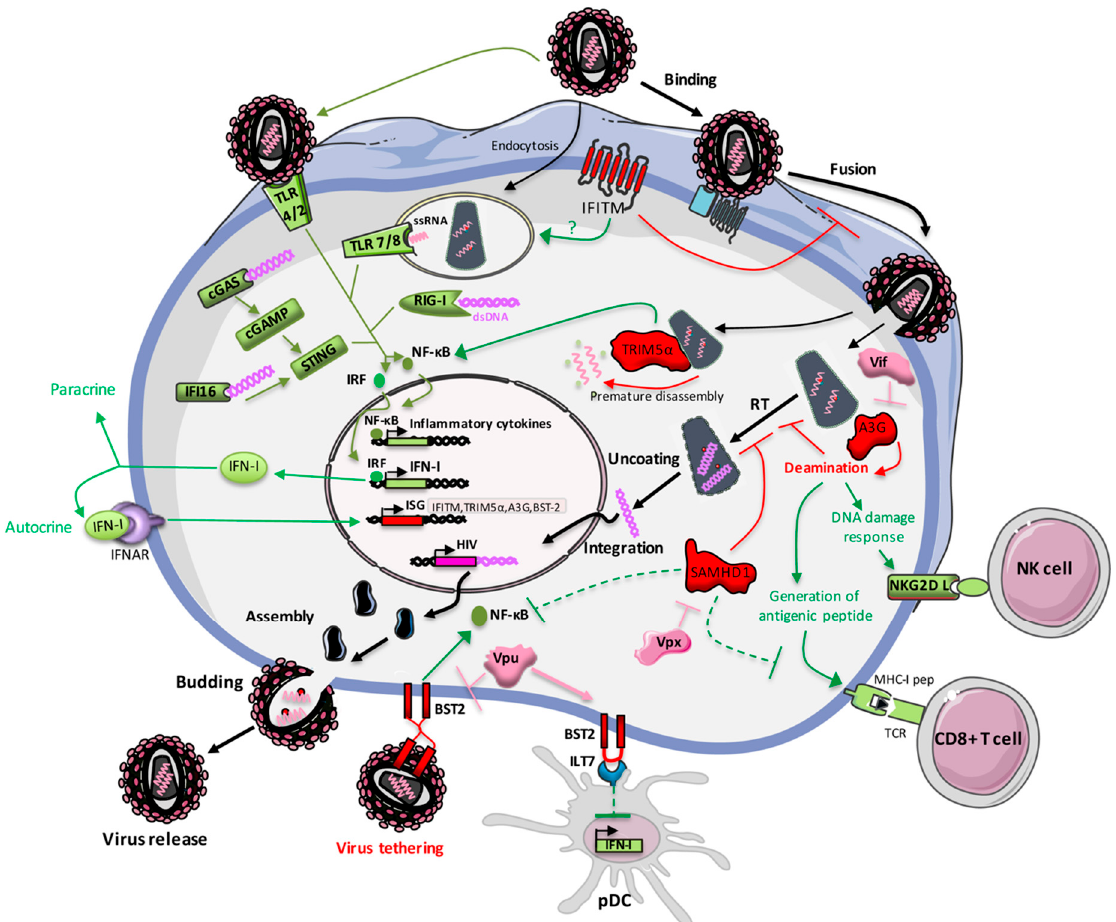
Figure 2. Schematic representation of HIV sensing by PRRs leading to the expression of antiviral restriction factors and shaping of immunity by restriction factors. Detection of HIV PAMPs by PRRs leads to activation of the transcription factors IRF and NF- κ B driving the expression of IFN-I and inflammatory cytokines, respectively. IFN-I binds to IFNAR (IFN- α / β receptor chain) and activates transcription of interferon-stimulated genes (ISGs) including the restriction factors interferon-inducible transmembrane (IFITM) proteins, tripartite motif (TRIM)5 α , apolipoprotein B mRNA-editing enzyme catalytic subunit-like 3G (APOBEC3G / A3G) and bone marrow stromal antigen 2 (BST-2). Antiviral functions of restriction factors are indicated by red arrows. Feedback of restriction factors on immunity are depicted by green arrows (induction: solid lines, inhibition: dotted lines). Counteractions by viral proteins are depicted in pink. Only restriction factors that are both induced by immunity and have an e ff ect on immunity are illustrated. pDC: plasmacytoid dendritic cells, NK: natural killer cells, RT: reverse transcription, TLR: Toll-like receptors, RIG-I: retinoic acid-inducible gene I, cGAS: cyclic guanosine monophosphate (GMP)-adenosine monophosphate (AMP) synthase, cGAMP: cyclic GMP-AMP, STING: stimulator of interferon genes, IFI16: interferon gamma inducible protein 16, IRF: IFN-regulatory factor, ssRNA: single-stranded RNA, dsDNA: double-stranded DNA, TCR: T cell receptor, MHC-I pep: major histocompatibility complex I associated with a